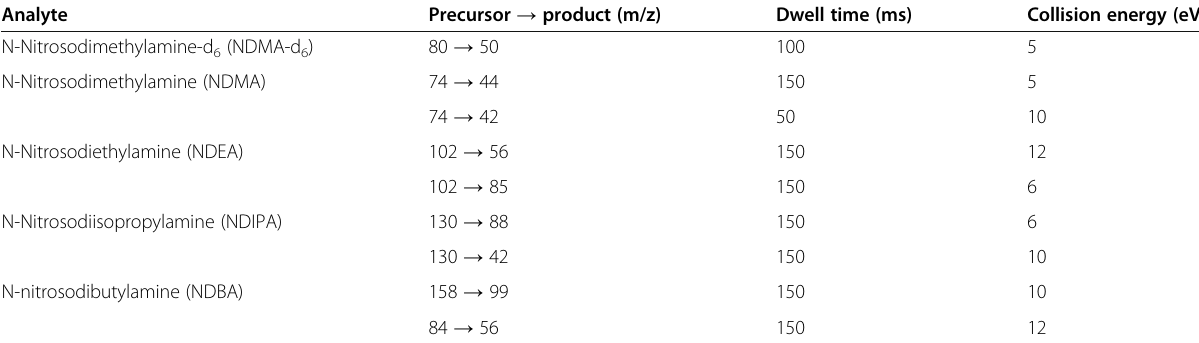
Table 2 Multiple reactions monitoring (MRM) transitions and optimized collision energy for four N-nitrosamine GTIs and the internal standard (NDMA-d 6 )